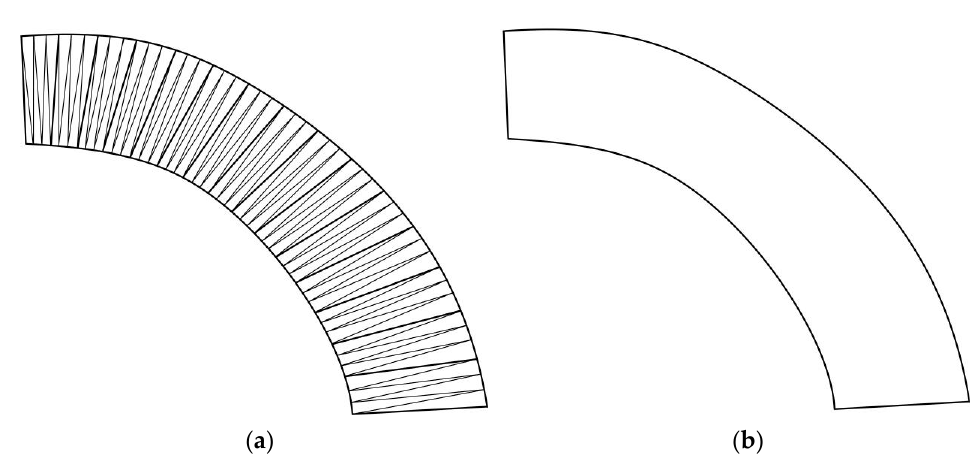
Figure 8. An example of boundary extraction from a projected spiral stair. ( a ) The projected cross-floor elements. ( b ) The extracted boundary.